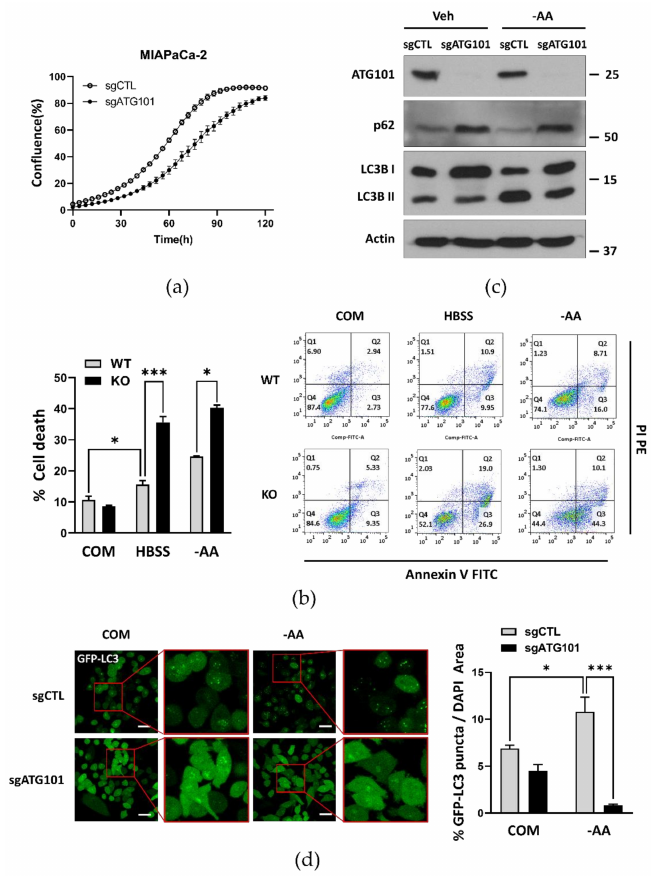
Figure 1. Autophagy-related protein 101 (ATG101) is required for autophagy to promote cell growth and survival. ( a ) Knockout of ATG101 (sgATG101) in MIA PaCa-2 cells using the Lenti-CRISPR system reduced proliferation rate compared to Control (sgCTL) MIA PaCa-2 cells as measured by the IncuCyte TM analyzer. MIA PaCa-2 cells stably ex- pressing GFP-LC3 were used. Cell confluence levels were measured in real-time and expressed as a proportion (%) of complete cell coverage. Error bars indicate the mean ± SEM of three independent experiments. ( b ) Knockout of ATG101 in MIA PaCa-2 cells also enhanced apoptotic death rate under nutrient deprivation as measured by Annexin V/propidium iodide (PI) staining and flow cytometry. WT or ATG101 KO MIA PaCa-2 cells were plated overnight and then incubated in HBSS or the medium without amino acids (amino acid deprivation, − AA) for 48 h. Error bars indicate the mean ± SEM of three independent experiments. * p < 0.05; *** p < 0.001. ( c ) ATG101 knockout (KO) altered the levels of autophagy markers as measured by western blotting. Cell lysates prepared from Control (sgCTL) or ATG101 KO (sgATG101) stably expressing GFP-LC3 MIA PaCa-2 cells cultured in complete medium(COM) and in amino acid-deprived medium (–AA) for 4 h, were immunoblotted for ATG101, p62, LC3B, and β -actin (gel loading control). ( d ) ATG101 KO reduced the formation of autophagosomes as measured by GFP-LC3 puncta. Control (sgCTL) or ATG101 KO (sgATG101) MIA PaCa-2 cells stably expressing GFP-LC3 were seeded overnight and subsequently starved in amino acid-deprived medium (–AA) for 4 h. Cell nuclei were stained with Hoechst 33342, and images were acquired using a confocal fluorescence microscope. At least five distinct regions were imaged per condition and quantified. Scale bar: 20 µ m. GFP-LC3 puncta area was normalized to the Hoechst 33,342 stained area and is presented as a percentage on the quantification graph. Error bars indicate the mean ± SEM of three independent experiments. * p < 0.05; *** p <